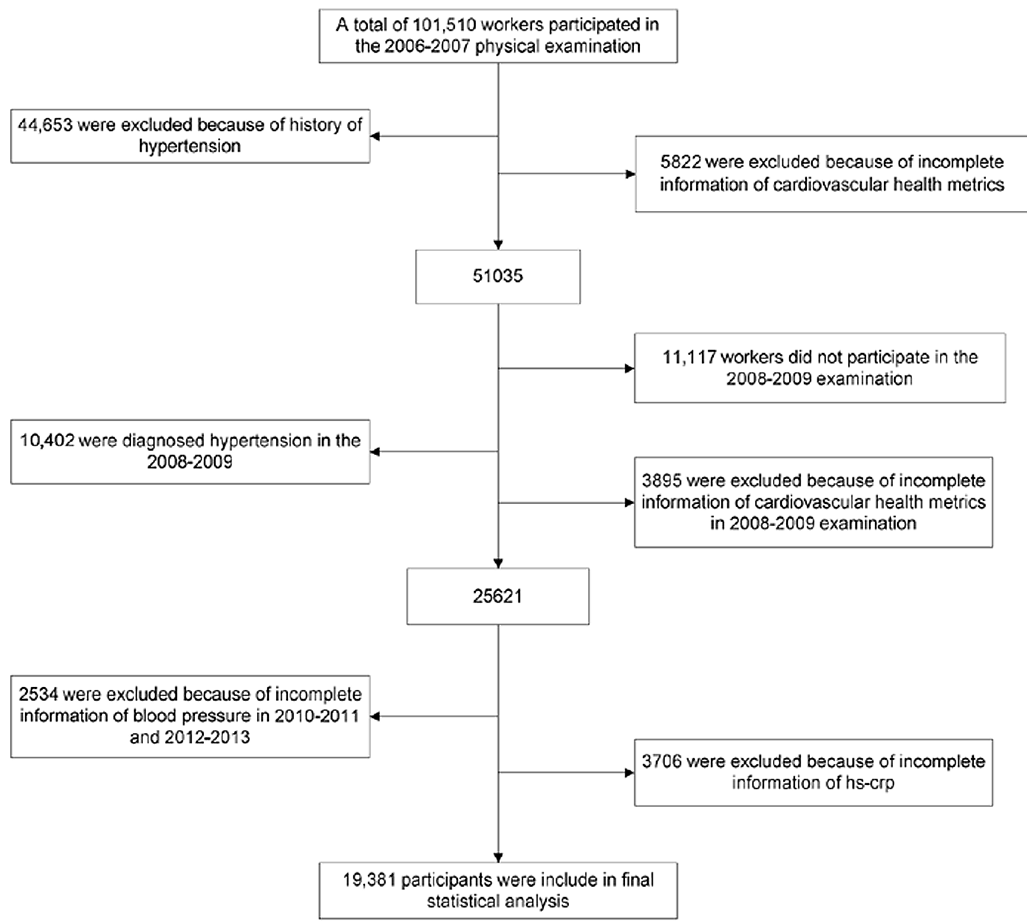
Fig 1. Selection of Kailuan study participants for